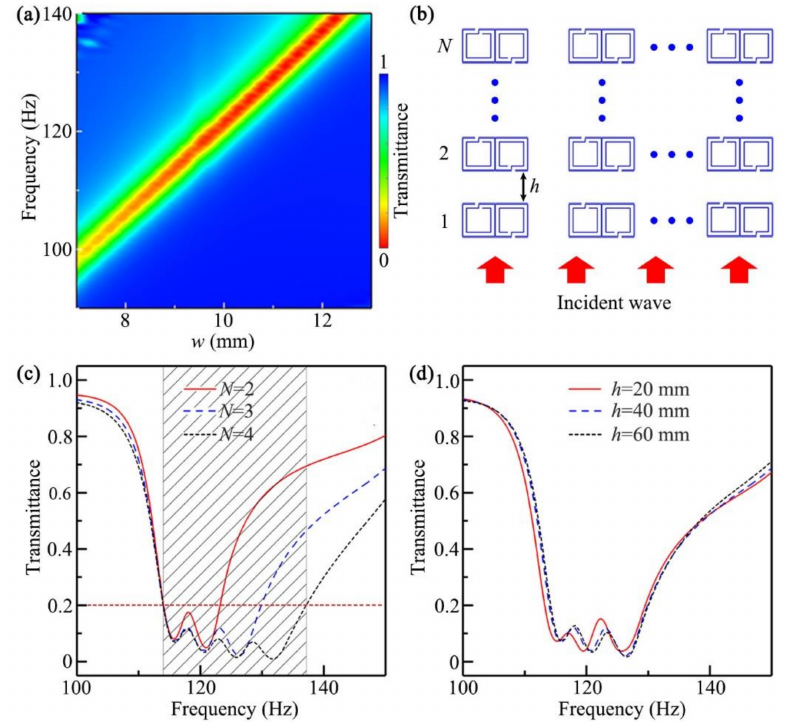
Figure 4. ( a ) Simulated transmittance spectra through a single-layer, open barrier with different values of w ; ( b ) schematic of a multilayer, open barrier composed of N -layer units; ( c ) simulated transmittance spectra of the multilayer barriers with N = 2 (red solid line), 3 (blue dashed line), and 4 (green short dashed line); ( d ) simulated transmittance spectra of the barriers ( N = 3) with h = 20 (red solid line), 40 (blue dashed line), and 60 mm (green short dashed line).